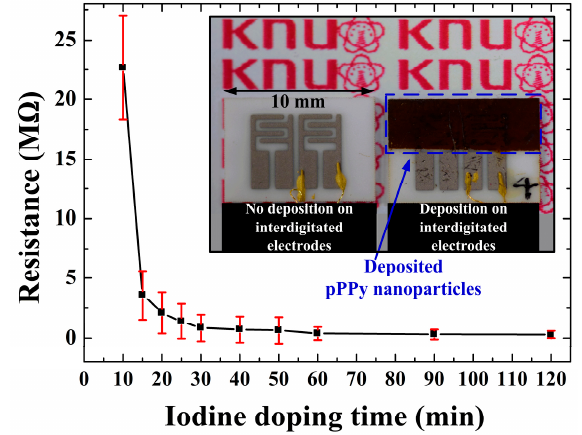
Figure 7. Changes in the resistance of pPPy nanofibers and nanoparticle thin films on substrates of interdigitated gas sensor electrodes under various iodine exposure (doping) times prepared using proposed APPJs with the insulating substrate holder placed inside the glass tube.